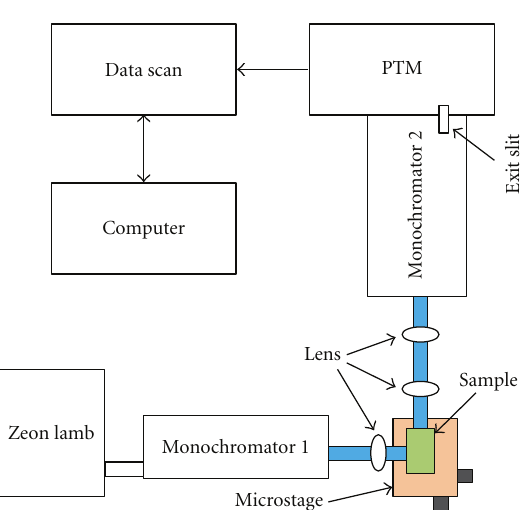
Figure 2: Experimental setup block